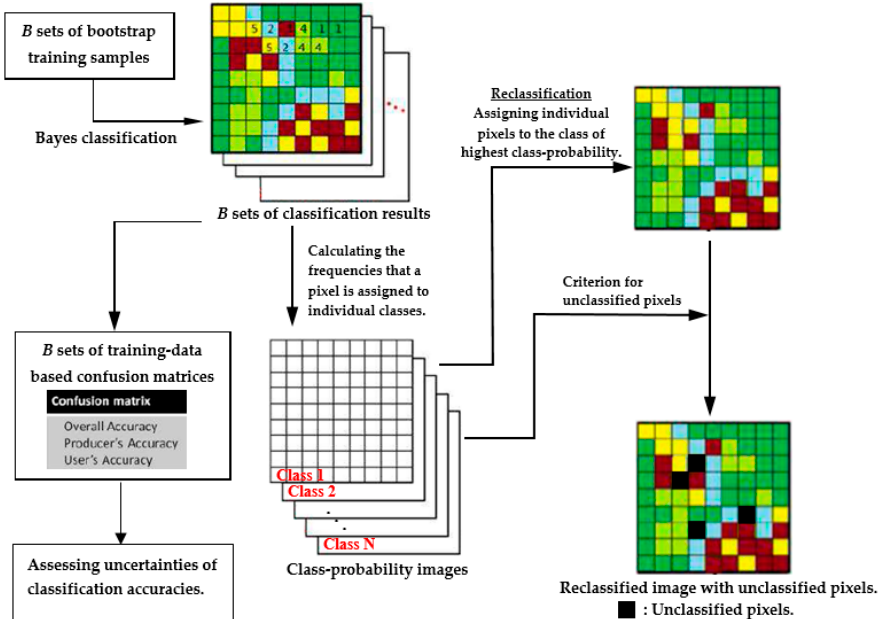
Figure 6. Flowchart of the bootstrap-based LULC reclassification approach.